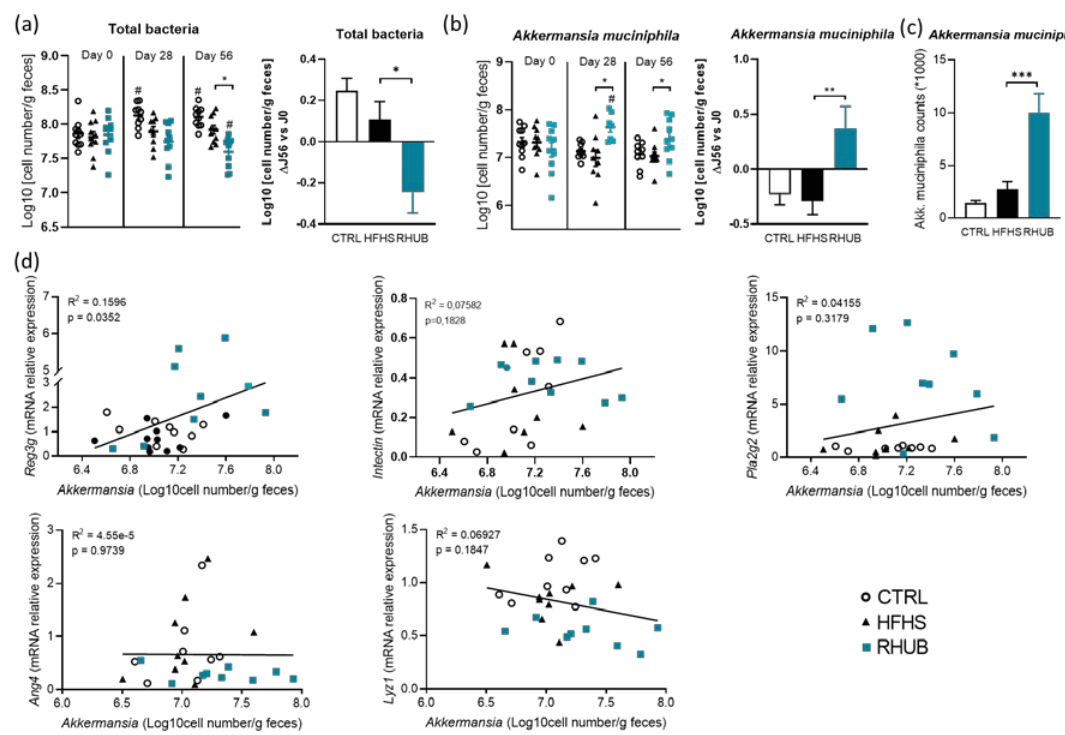
Figure 6. Rhubarb root extract promotes the growth of Akkermansia muciniphila in response to HFHS ( a ) Total bacteria measured by qPCR at day 0, day 28 and day 58 of experiment (Left panel). Difference of total bacteria between day 56 and day 0 (right panel). ( b ) qPCR analysis of Akkermansia muciniphila in the fecal content (left panel). Difference in Akkermansia muciniphila between day 0 and day 56 (right panel). ( c ) Relative abundance (percentage of 16S rRNA gene sequences) of Akkermansia muciniphila measured in fecal content of mice after 56 days of experimentation. ( d ) Correlation between Akkermansia muciniphila and Reg3y , Pla2g2 , Intectin , Ang4 and Lyz1 mRNA expression, respectively. The p-value and R 2 come from linear regression. White, CTRL fed mice; Black, HFHS fed mice and Blue, HFHS fed mice supplemented with rhubarb. Data represent mean ± SEM. * p ≤ 0.05, ** p ≤ 0.01, *** p ≤ 0.005. R², Coefficient of determination.